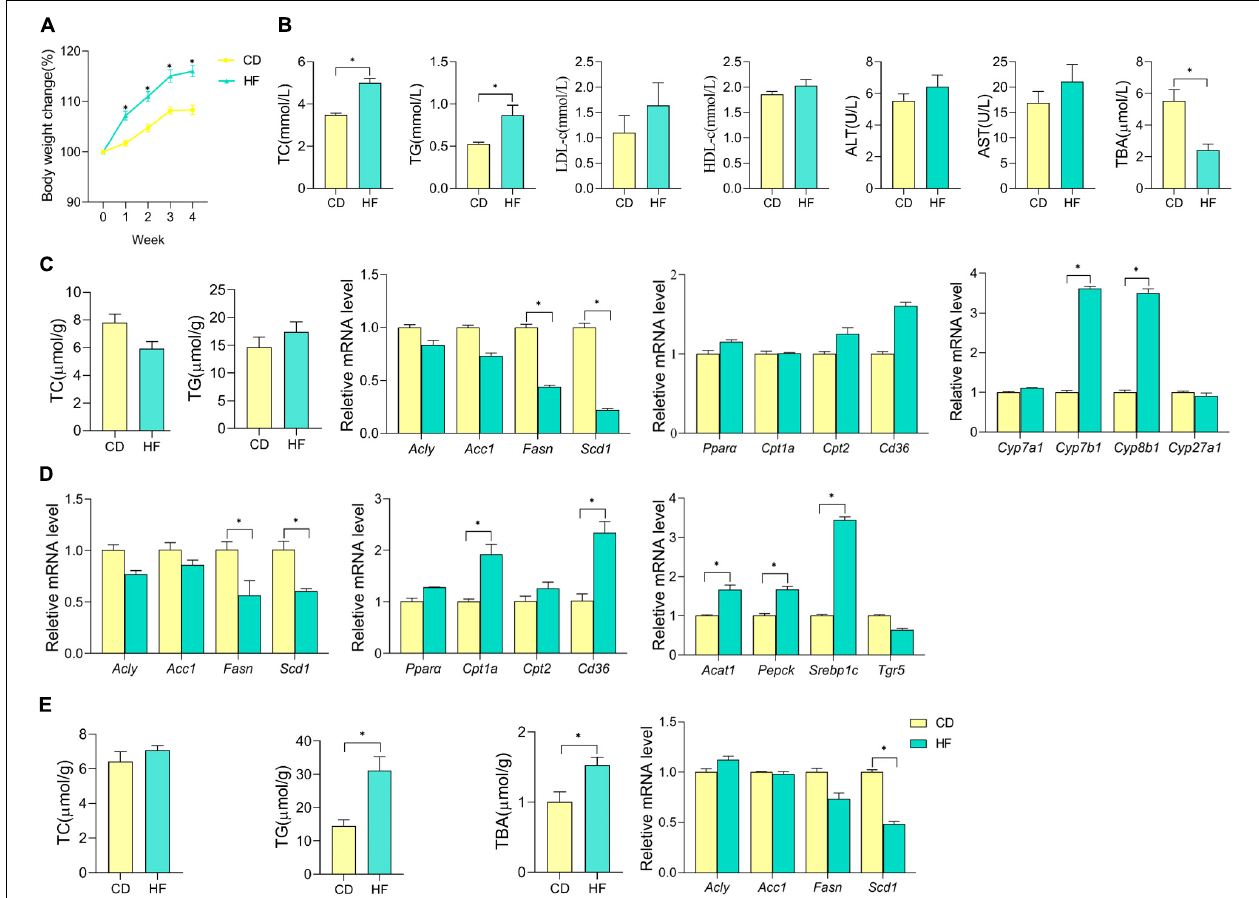
FIGURE 1 | Effect of HF on the blood, liver, ileum, and colon lipid metabolism in mice. (A) Body weight changes in mice on CD or HF for 4 weeks. (B) Cholesterol (TC), triglyceride (TG), low-density lipoprotein cholesterol (LDL-c), high-density lipoprotein cholesterol (HDL-c), alanine aminotransferase (ALT), and aspartate aminotransferase (AST) contents in the serum of each group of mice. (C) Cholesterol (TC) and triglyceride (TG) contents in the liver of each group of mice; hepatic mRNA expression of genes involved in lipid metabolism and BA synthesis, and data were from seven pooled samples of each group. (D) Ileum mRNA expression of genes involved in lipid and carbohydrate metabolism in each group of mice (data were from seven pooled samples of each group). (E) Cholesterol (TC), triglyceride (TG), and total bile acid (TBA) contents in the colon; colonic mRNA expression of genes involved in lipid metabolism in each group of mice (data were from seven pooled samples of each group). n ≥ 6. The data were shown as mean ± SEM. ∗ p < 0.05. CD, control diet group; HF, high-fat diet